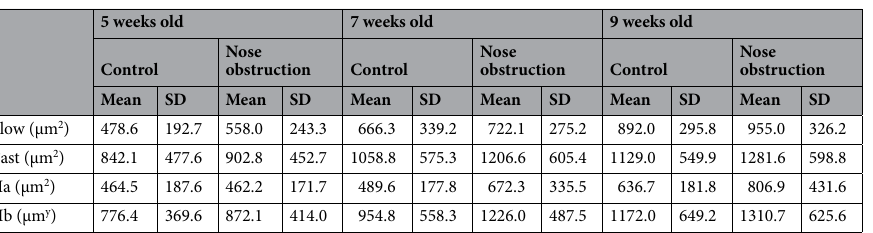
Table 5. Cross-sectional values of genioglossus muscle fibers. Data presented as mean ± standard deviation (SD). Slow slow type muscle fiber, Fast fast type muscle fiber, IIa fast-twitch IIa type muscle fiber, IIb fast- twitch IIb type muscle fiber.